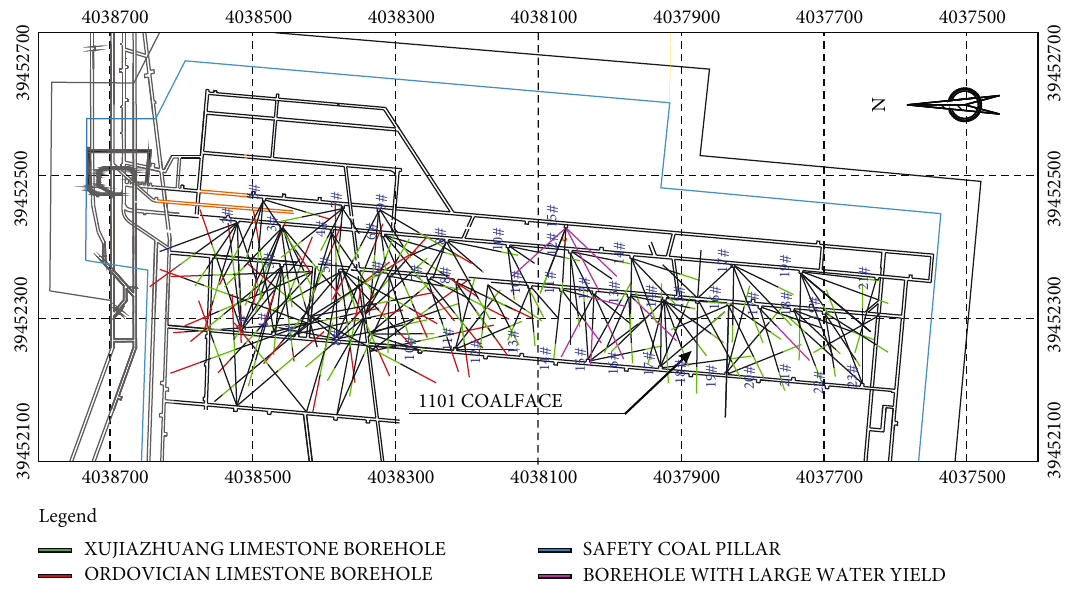
Figure 8: Layout of the inspection borehole in the Xujiazhuang limestone aquifer.